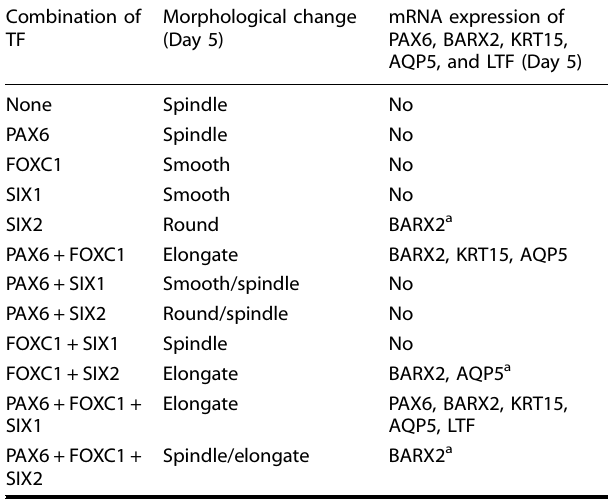
Table 2. Morphological changes of cells transfected with each transcription factor and their combinations in hESCs Combination of